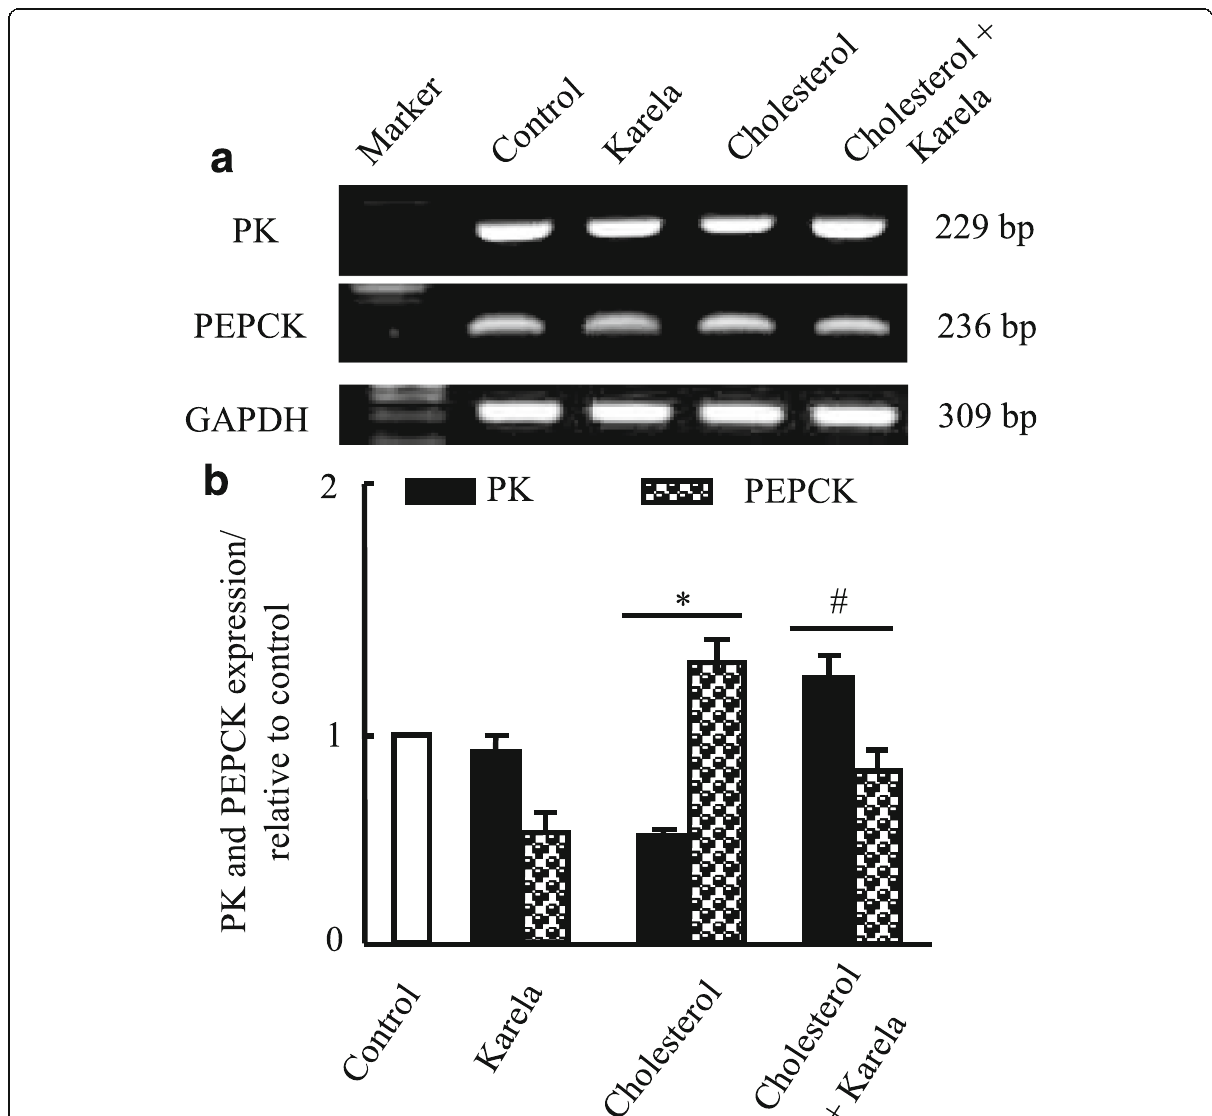
Fig. 4 Protective effect of karela on changes in PK and PEPCK expression induced by hypercholesterolemia in liver. Hypercholesterolemic rats were administered karela for 4 consecutive weeks. Total RNA was extracted from liver tissues and the expressions of PK and PEPCK were analyzed by semi-quantitative RT-PCR analysis. Values are means ± SE of 10 rats. * P < 0.05 Vs control group; # P < 0.05 VS hypercholesterolemic group. Upper panels ( a ) are mRNA expression of examined genes. Lower columns ( b ) are densitometric analysis of gene expression for upper